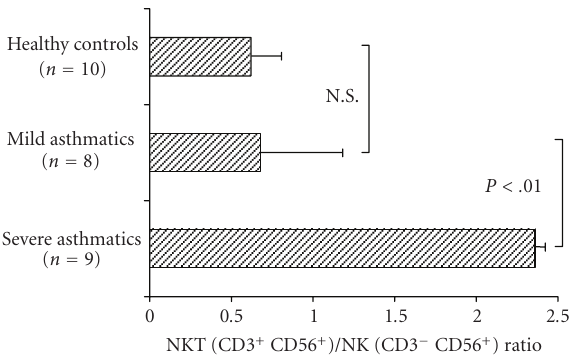
Figure 1: Ratio of NKT (CD3 + CD56 + ) cells and NK (CD3 − CD56 + ) cells in the induced sputum of patients with severe asthma, mild asthma, and healthy